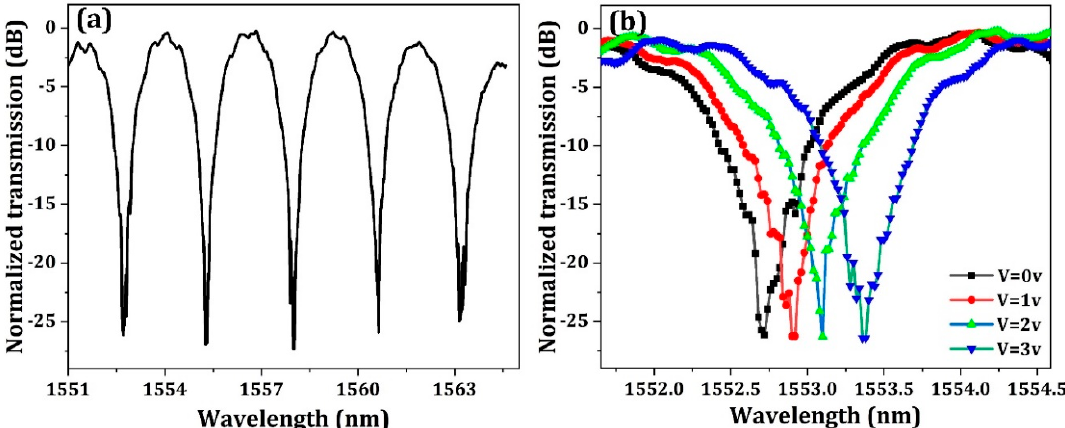
Figure 7. Static characteristics of the modulator: ( a ) Spectra response of modulator with 2.4 nm FSR, ( b ) Spectra response of modulator at different reversed voltages.